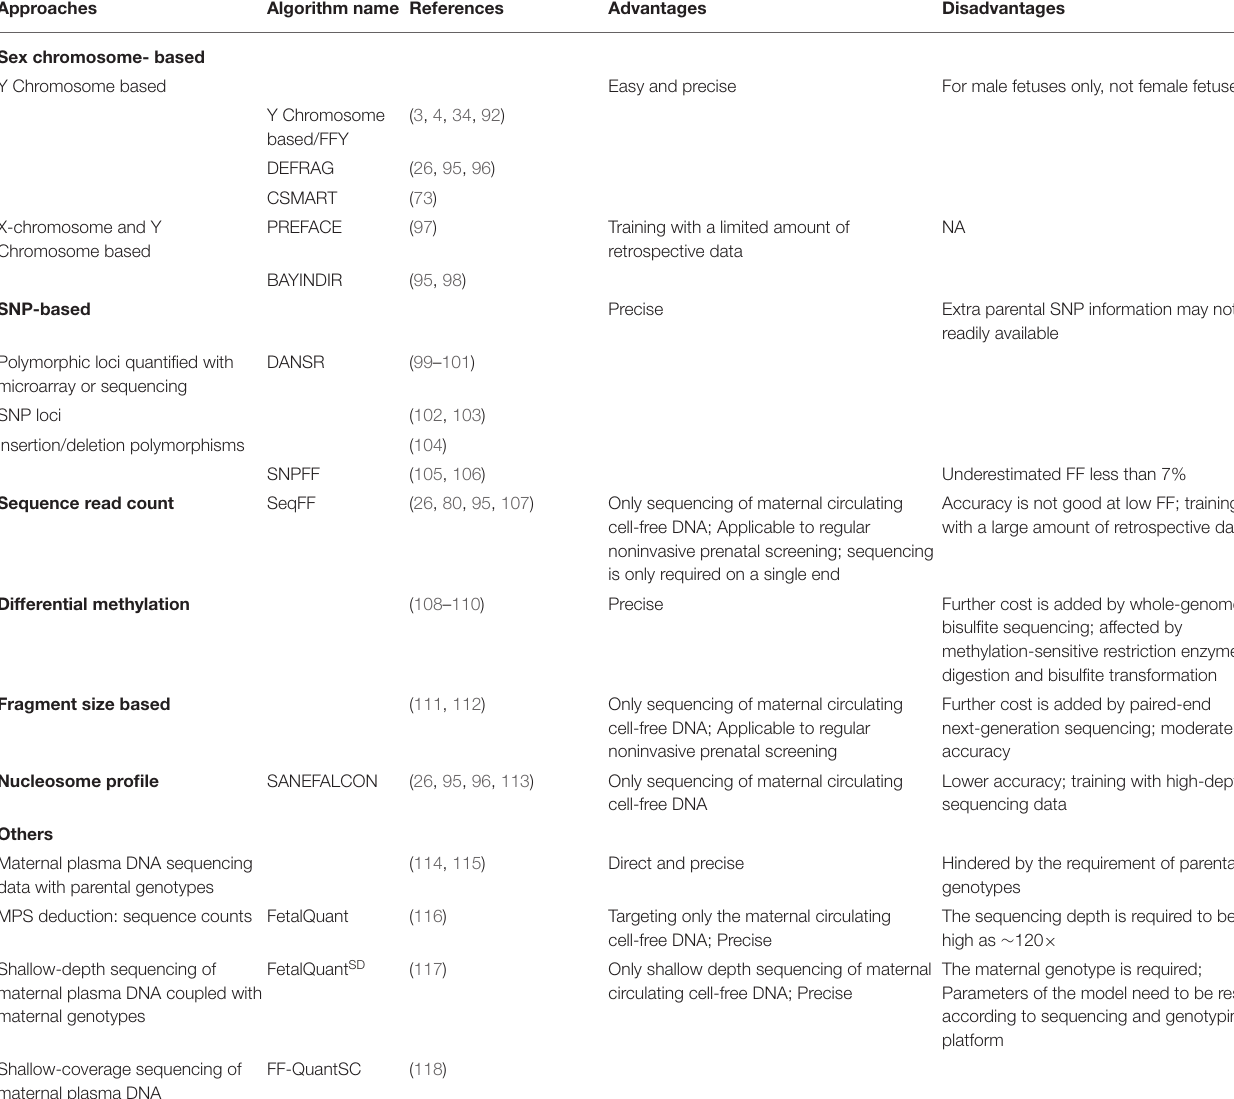
TABLE 4 | Approaches for evaluating fetal fraction (93,